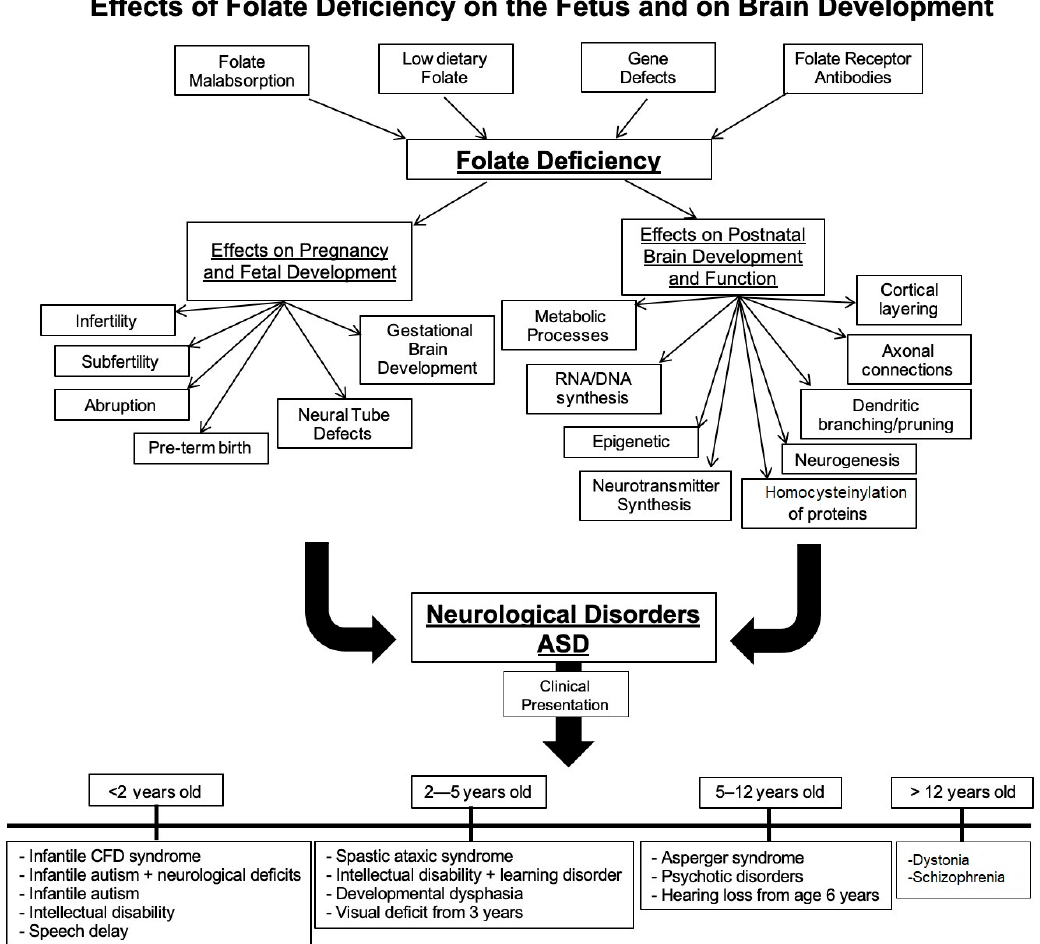
Figure 1. Effects of folate deficiency on the fetus and on brain development. Multiple causes lead to systemic as well as fetal folate deficiency. Folate receptor autoantibodies can block folate transport to the fetus and to the fetal as well as neonatal brain. In addition to folate deficiency, immune-mediated inflammation can contribute to the pathology. This has multipronged effects on brain development and function.